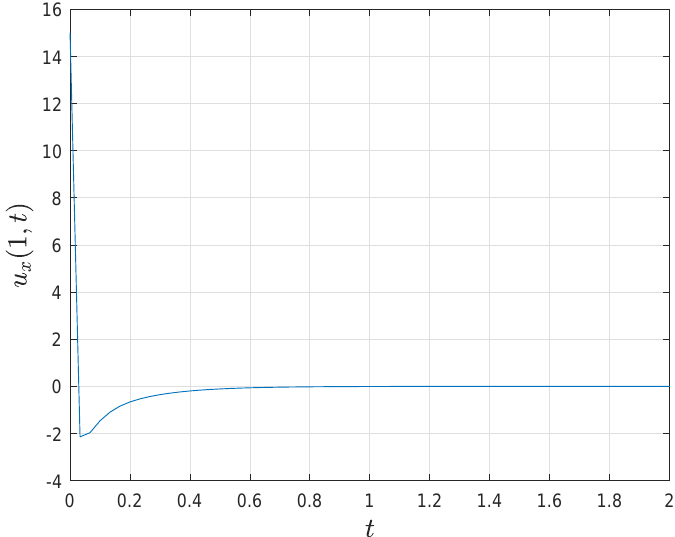
Figure 4. Closed-loop control effort at the right hand side boundary from the R-A-D